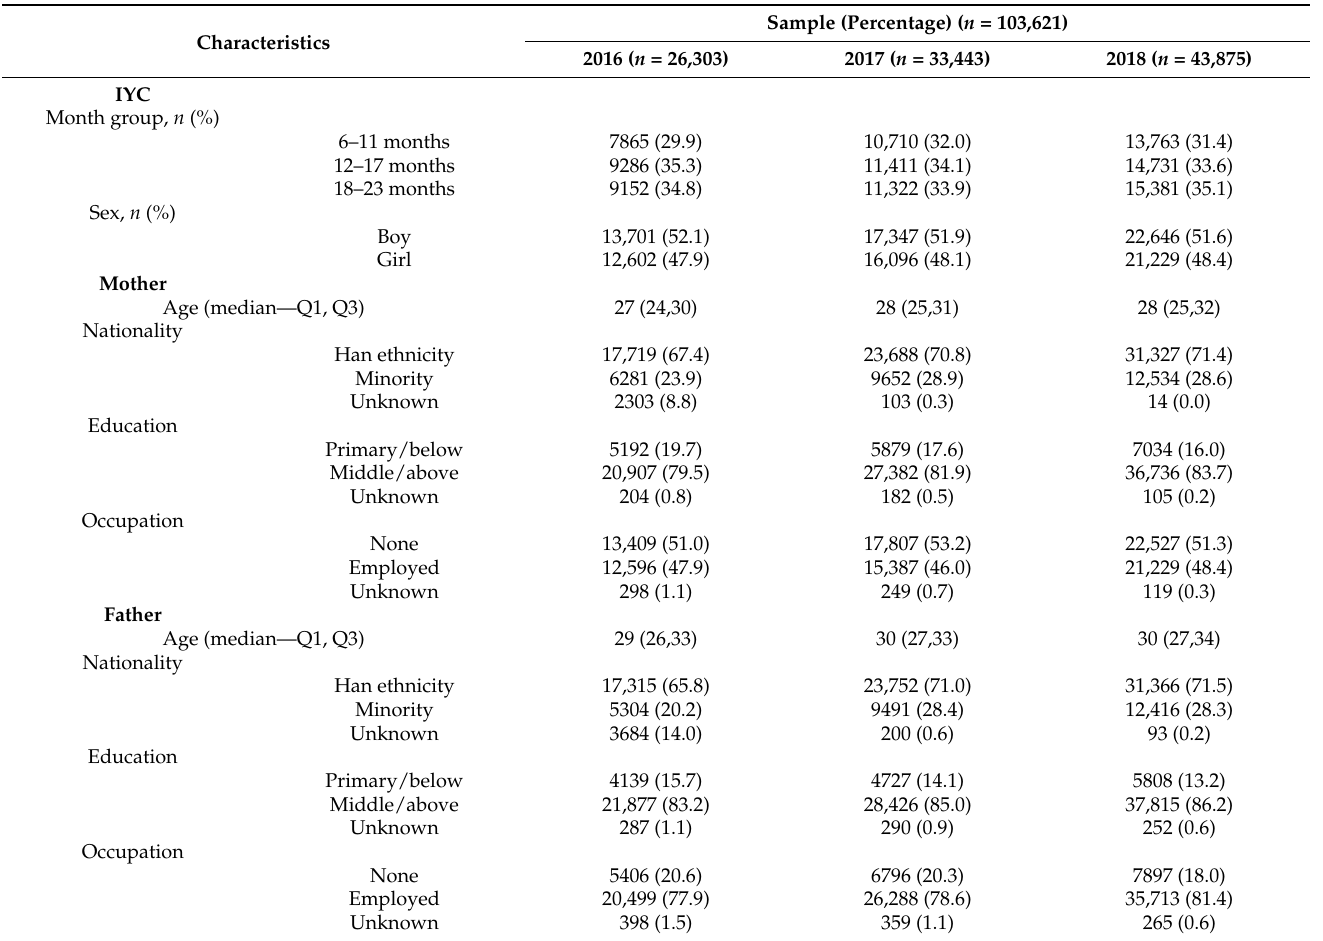
Table 1. Characteristics of the surveyed children and their caregivers ( n =